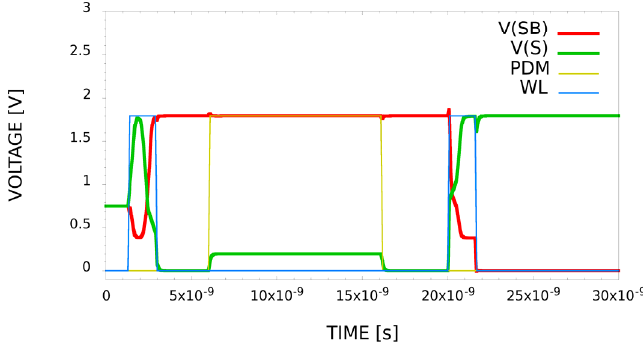
Table 3. Effectiveness of the different test methods with respect to the R2 defect.